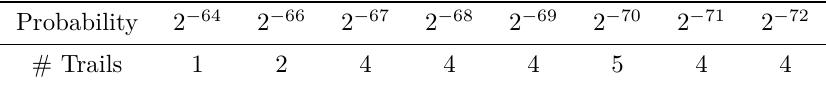
Table 8: Differential effect for 338 rounds